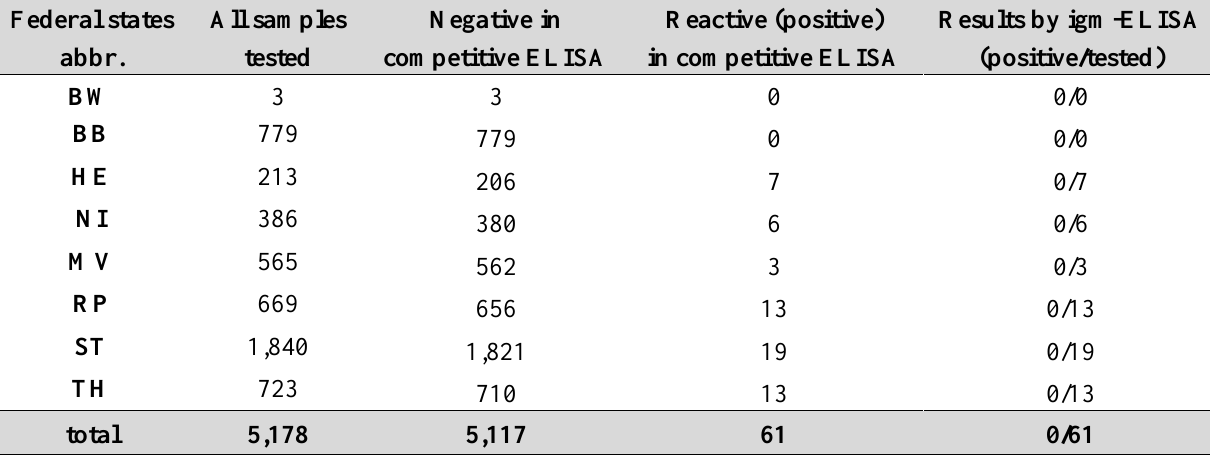
Table 2. Results by commercial WNV